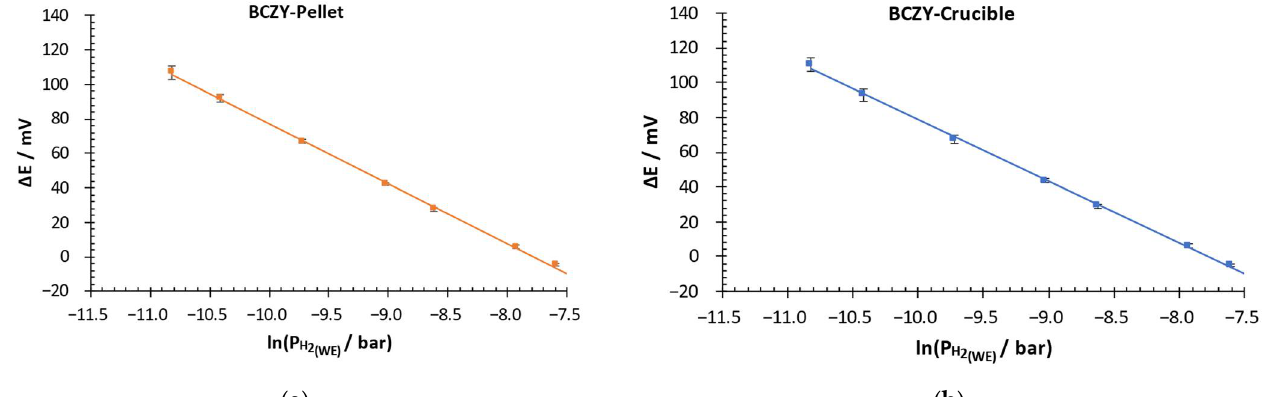
Figure 7. Potential difference over the logarithm of the H 2 partial pressure in the WE of ( a ) BCZY- Pellet and ( b ) BCZY-Crucible sensors.